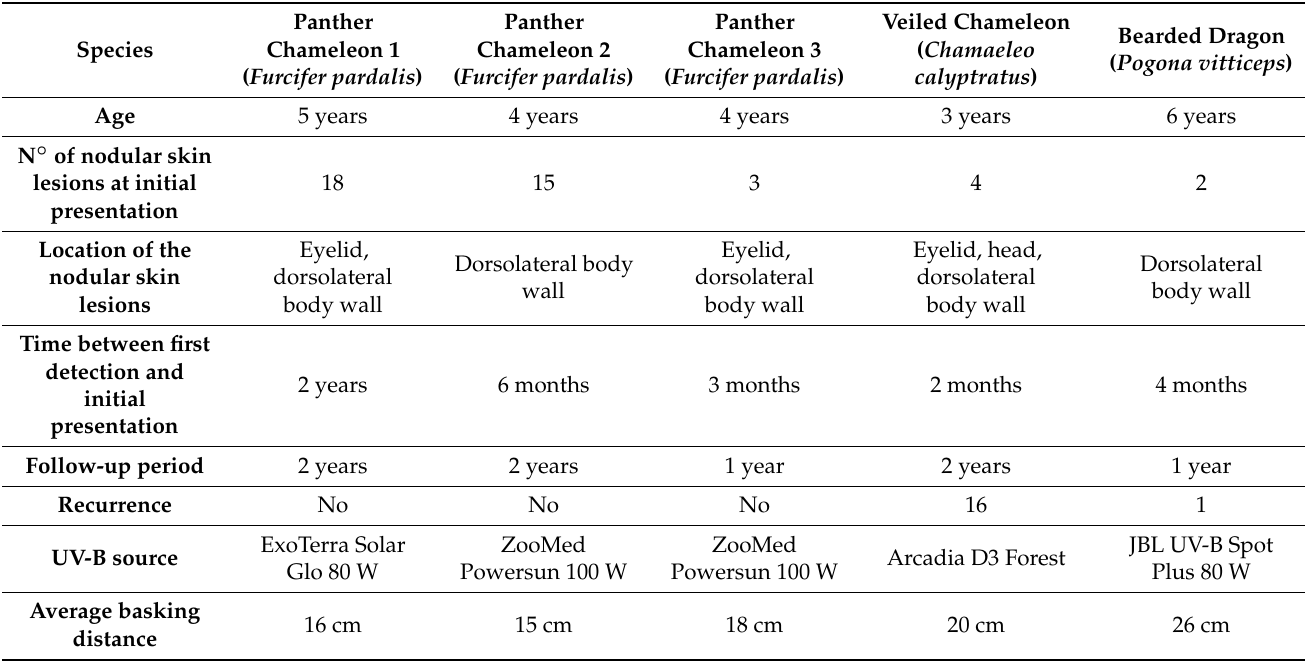
Table 1. Signalment of five lizards that were presented with nodular skin lesions. The number and distribution of skin lesions, the interval between detection of the skin lesions and initial presentation, the follow-up period, and recurrence are specified for each case, as well as the type of ultraviolet B